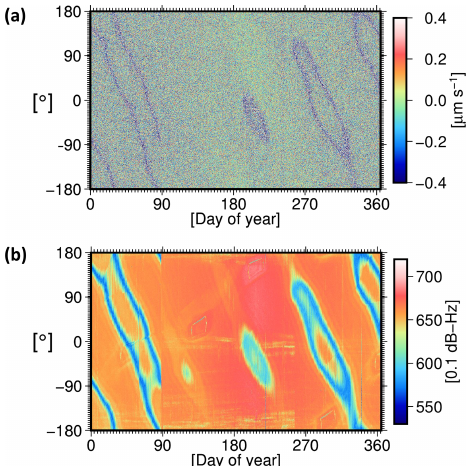
Figure 9. (a) Short timescale details of the residuals, (b) GRACE- B K-band SNR values. The values are plotted with respect to the GRACE-A argument of latitude for the time period